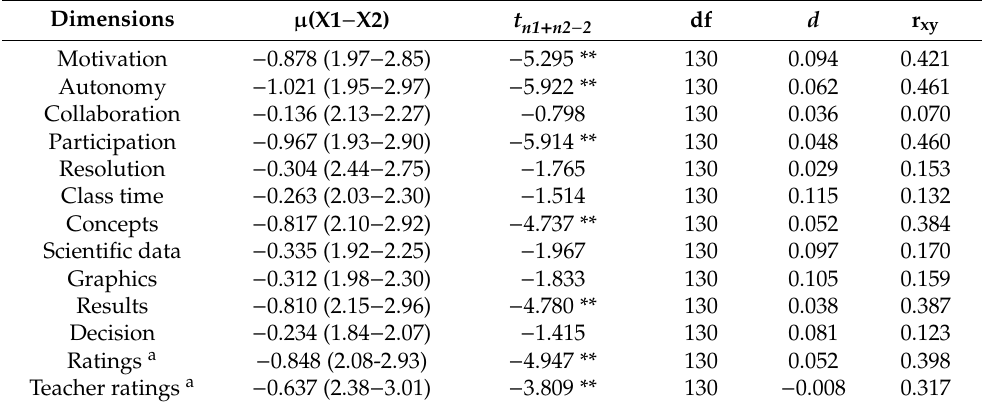
Figure 1. Comparison between control group and experimental group. Table 3. Study of the value of independence between control group and experimental